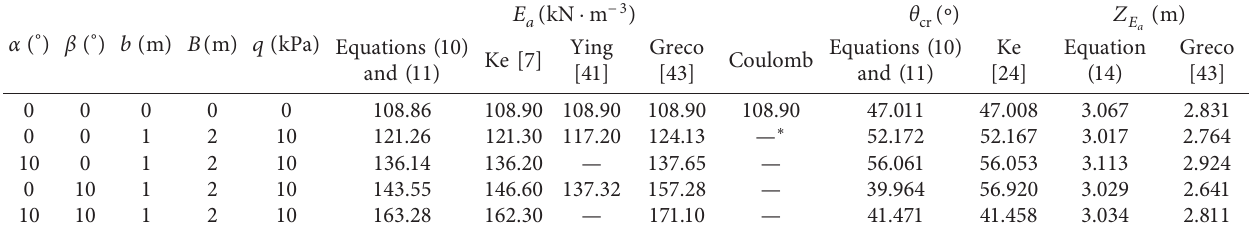
Table 2: Comparison of Coulomb’s active earth pressure results between previous studies and our work.